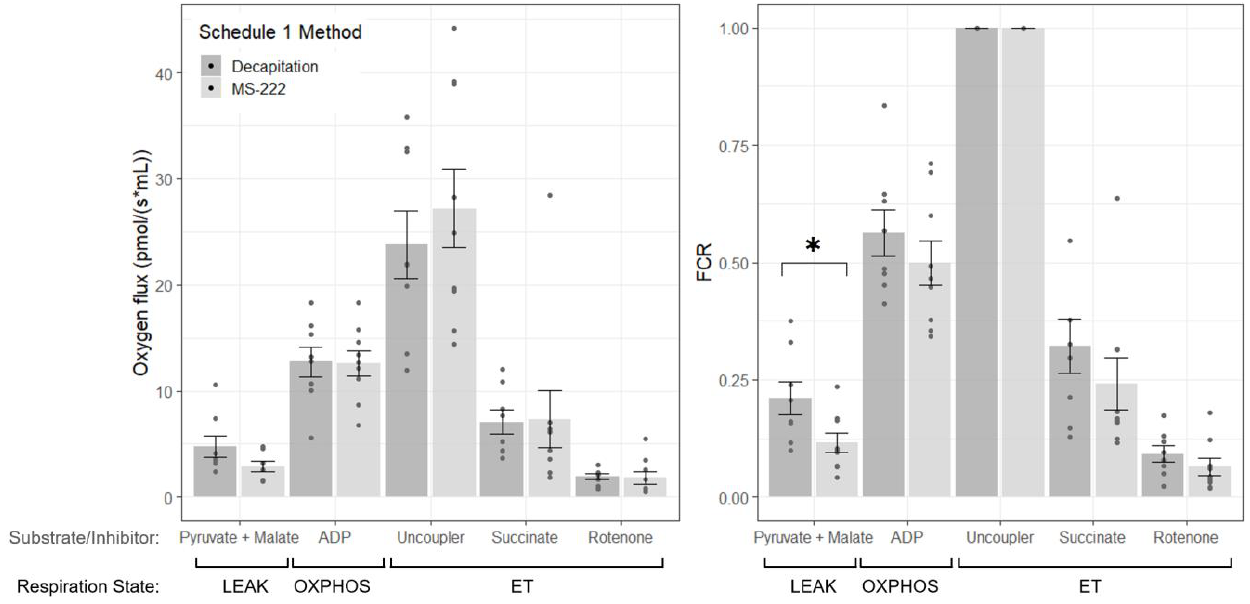
Figure 2. Mean oxygen flux and flux control ratios at LEAK, OXPHOS and ET respiration states in the brain of the stickleback with complex I substrates (pyruvate and malate) and complex II substrate (succinate). Average values per sample shown by points, n = 8 for decapitation (darker grey), n = 9 for MS-222 treated (lighter grey). Error bars show standard error. Significant differences ( p < 0.05) depicted by a star (*) (unpaired Student’s t -test).